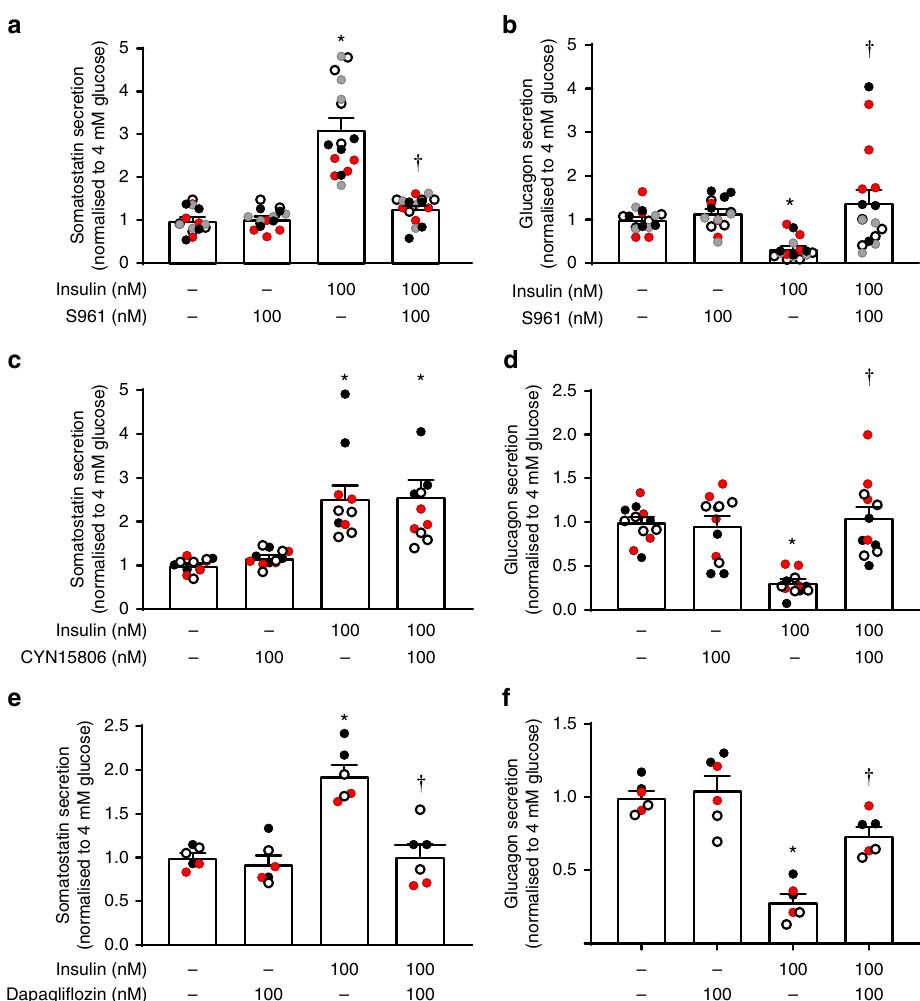
Fig. 7 Effects of insulin in human pancreatic islets. a , b Somatostatin ( a ) and glucagon secretion ( b ) at 4 mM glucose in the absence and presence of insulin and S961 as indicated using islets from four donors (three males/one female) with four separate experiments for each donors. c , d As in a , b but testing the effects of CYN154806 as indicated (three female donors, three separate experiments for each donor). Note that CYN154806 does not affect insulin- induced somatostatin secretion but reverses the inhibitory effect of insulin on glucagon secretion. e, f As in a , b but instead testing the effect of dapagli fl ozin (100 nM; two female and one male donors, two separate experiments for each donor (different colours)). Note that dapagli fl ozin reduces the stimulatory and inhibitory effects of insulin on somatostatin and glucagon secretion, respectively. In a – f , data have been normalised to 4 mM glucose alone. dot plots of individual experiments and/or mean values ± S.E.M. of all experiments with the experimental